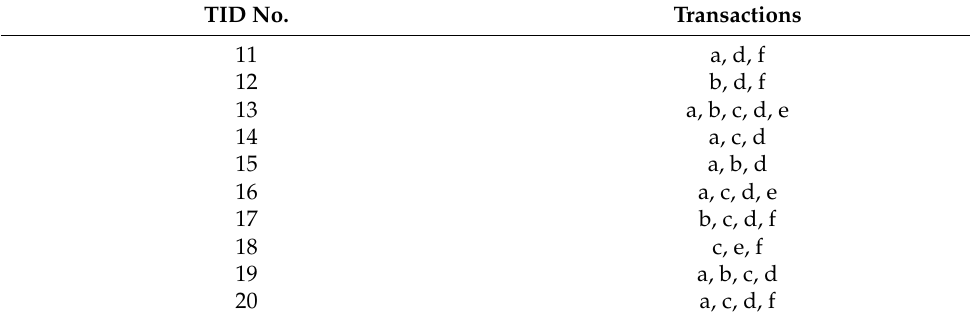
Table 4. Transaction dataset batch B. TID